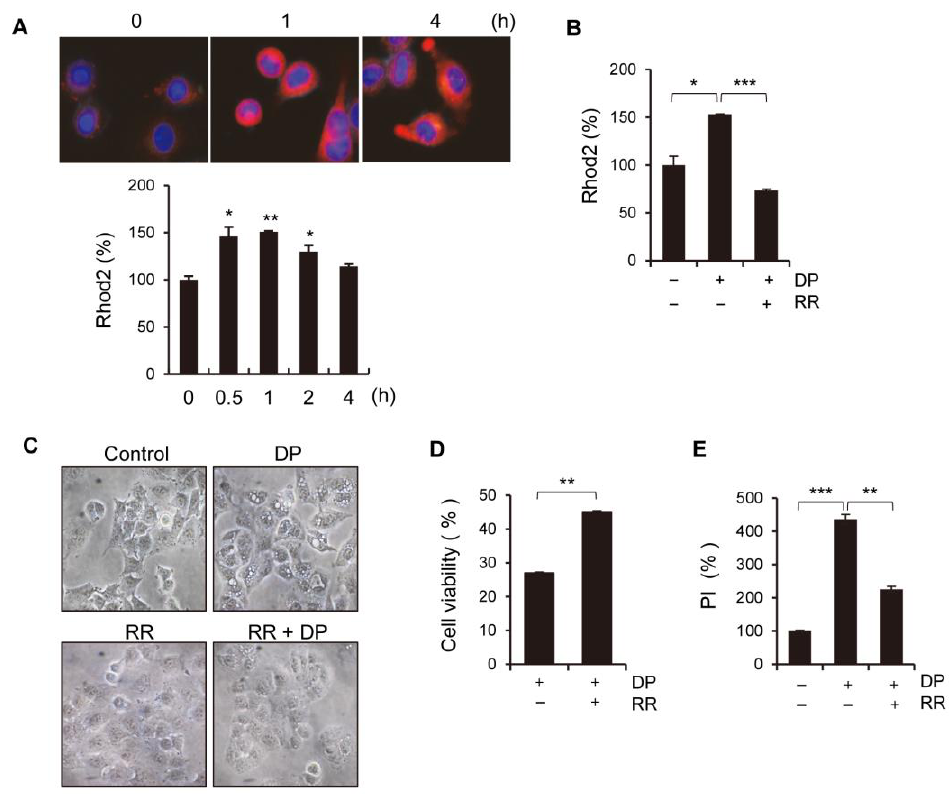
Figure 4. DP induces Ca 2+ uptake in mitochondria. ( A ) A549 cells were treated with 40 µ M DP for the indicated periods and stained with 1 µ g/mL Rhod-2 for fluorescence microscope (upper panel) and flow cytometry (lower panel) analysis. Nuclei were stained with Hoechst 33242 (blue) and mitochondrial Ca 2+ were stained with Rhod-2 (red). ( B ) The A549 cells were pretreated with 5 µ M ruthenium red (RR) and then treated with 40 µ M DP. ( C ) The cells were pretreated with RR and further treated with DP, and cell morphology was observed under a microscope (magnification, × 200). ( D ) The cells were pretreated with RR and then treated with DP for 24 h, and cell viability was assessed using the MTT assay. ( E ) The cells were pretreated with RR and then treated with DP for 24 h, and PI-positive cells were analyzed via flow cytometry. All data are expressed as the mean ± SD obtained from at least three independent experiments. Statistical differences were analyzed by two-way ANOVA with Tukey’s multiple comparisons test and presented as p < 0.05 (*), p < 0.01 (**), and p < 0.001 (***) when compared with the control.